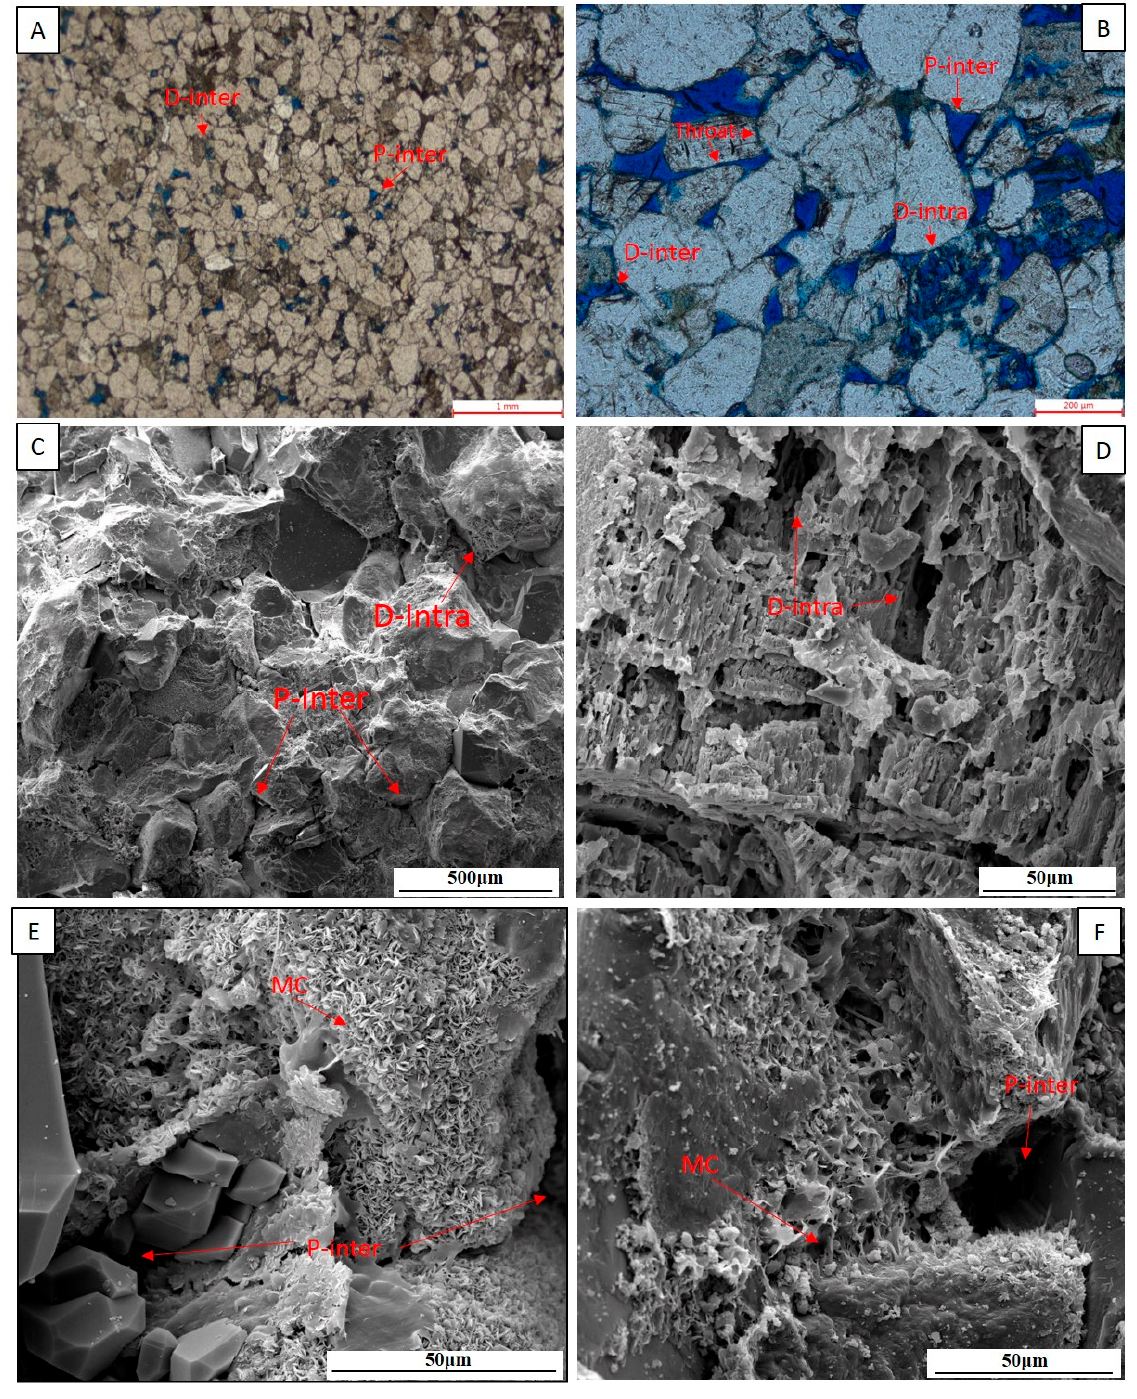
Figure 4. Pore type of the E 3 h tight sandstones in Xihu Sag. Legend: P-Inter, primary intergranular pores; D-Inter, intergranular dissolution pores; D-Intra, intragranular dissolution pores; MC, micropores within clay aggregates. ( A ) Full view with primary pores predominating, Well A 3961.62 m; ( B ) Primary intergranular pores, intergranular dissolved pores, intragranular dissolved pores, Well B 3742.45 m; ( C ) Full view with lithology dense, Well A 3600.7 m; ( D ) Pores formed by dissolution of alkali feldspar, Well C 3126.5 m; ( E ) Autogenous quartz, chlorite, and illite distributed in primary intergranular pores, chlorite distributed on the grain surface, Well A 3980.6 m; ( F ) micropores formed in illite Well A 3961